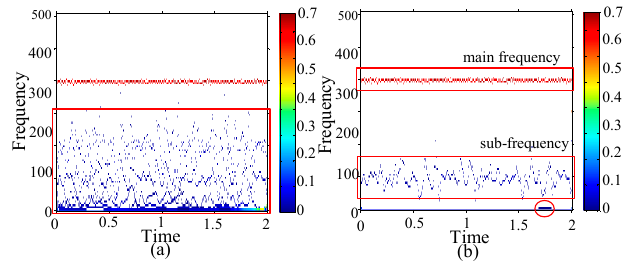
Figure 16. Seal damage ( a ) HHT spectrum ( b ) GEMD-HHT spectrum.